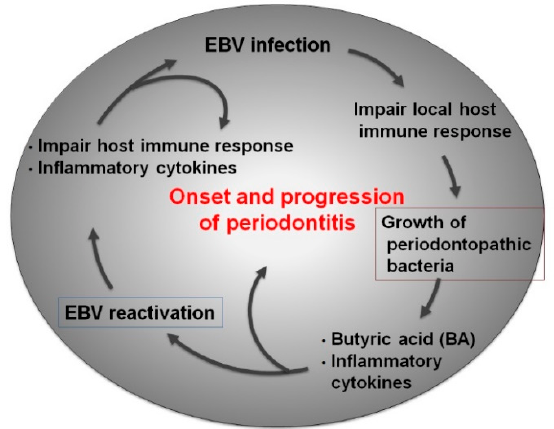
Figure 3. Interactions between bacteria and viruses in the oral cavity. The oral cavity is colonized by a wide variety of and numerous microbes, including oral bacteria, viruses, and fungi. Thus, in addition to host–microbial interactions, the interactions of herpesviruses such as EBV with periodontopathic bacteria have the potential to contribute to periodontitis pathogenesis.